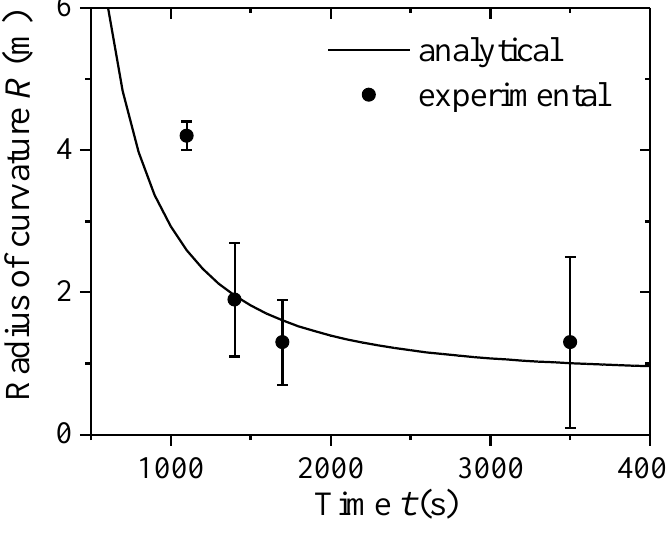
Figure 2. Radius of curvature of a DNA-microcantilever sensor as a function of adsorption time.